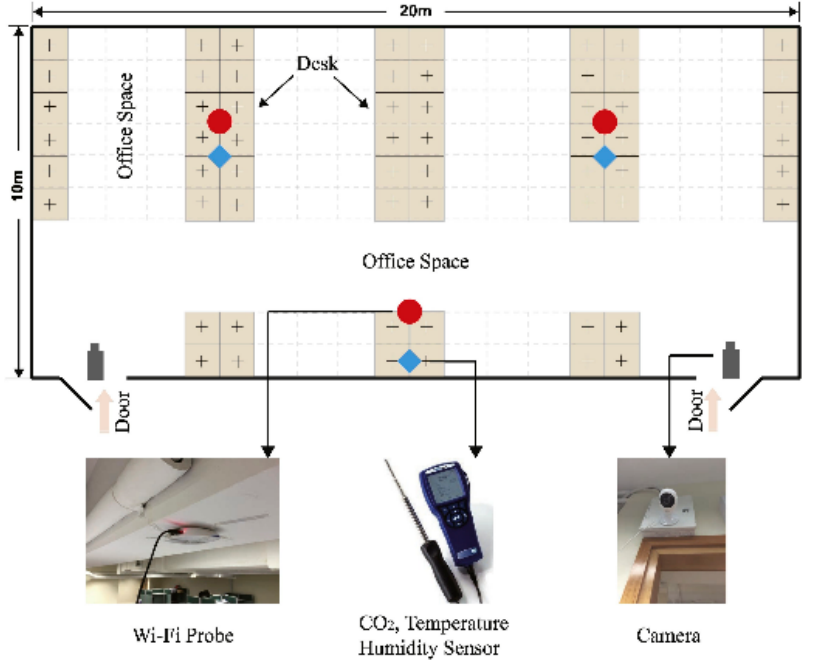
Figure 11. The layout of the experiment test bed in Refs. [126,127].